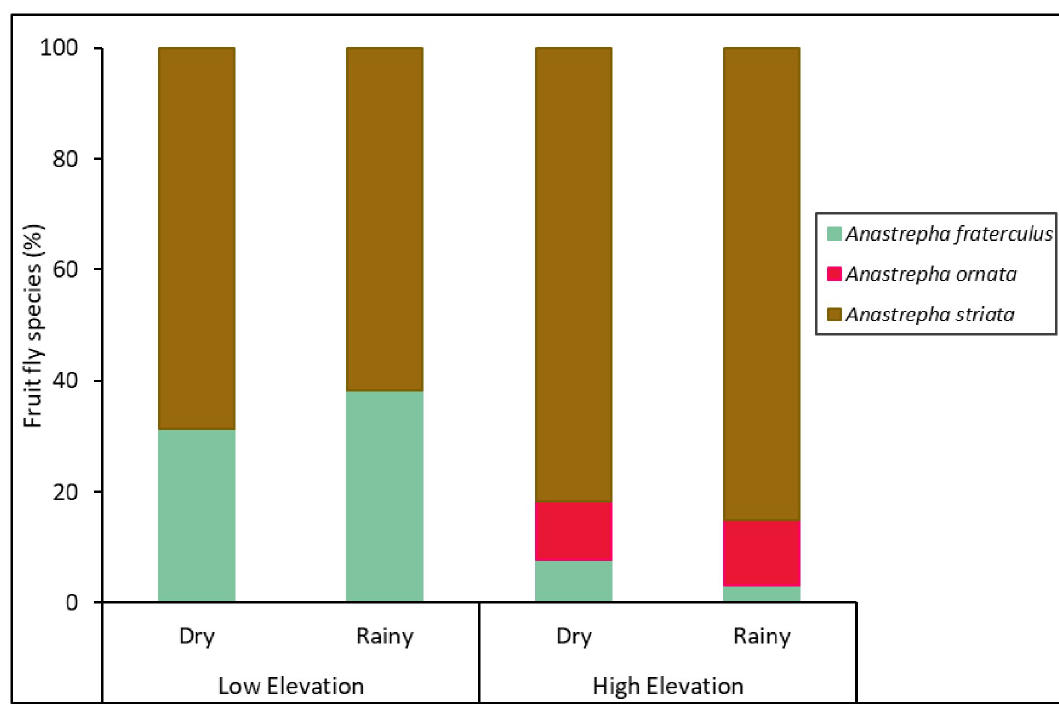
Fig 4. Fruit fly species composition in fruit. Percentage of fruit fly species that emerged in guava fruit collected at different elevations (low and high) and seasons (dry and rainy) from 2013–2014.